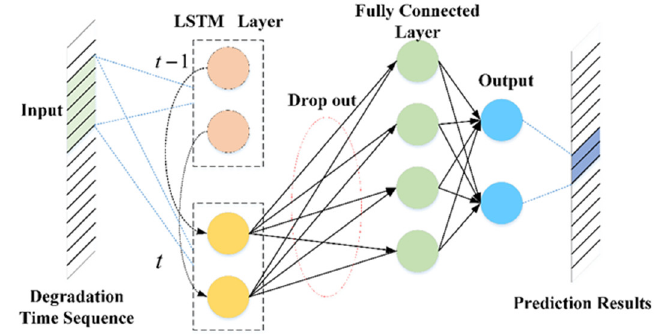
Figure 7. Network model for the pack state of health (SOH) prediction.